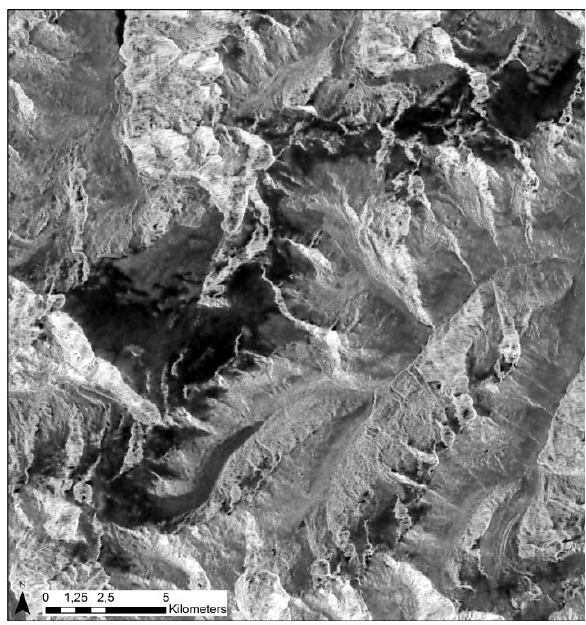
Figure 2. K 0 image of TSX image of 22 September 2014 Figure 3. K 0 image of RS2 image of 24 September